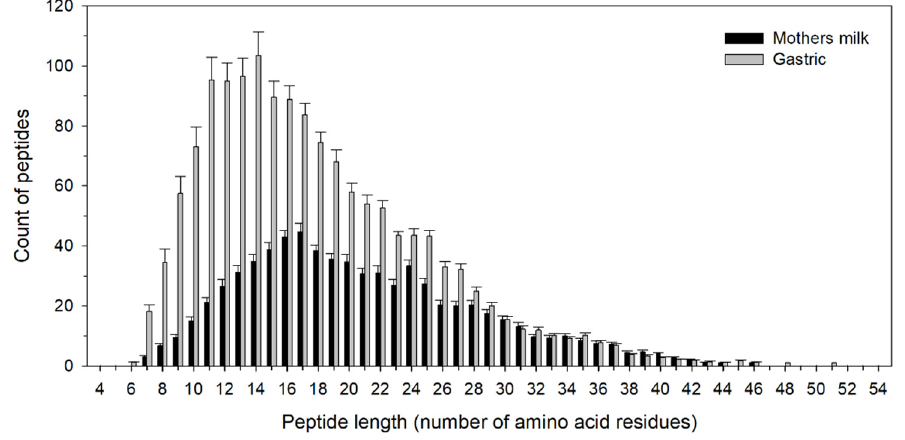
Figure 2. Distribution of peptide length in milk and gastric samples. Data are presented as mean ± standard error, n = 13.